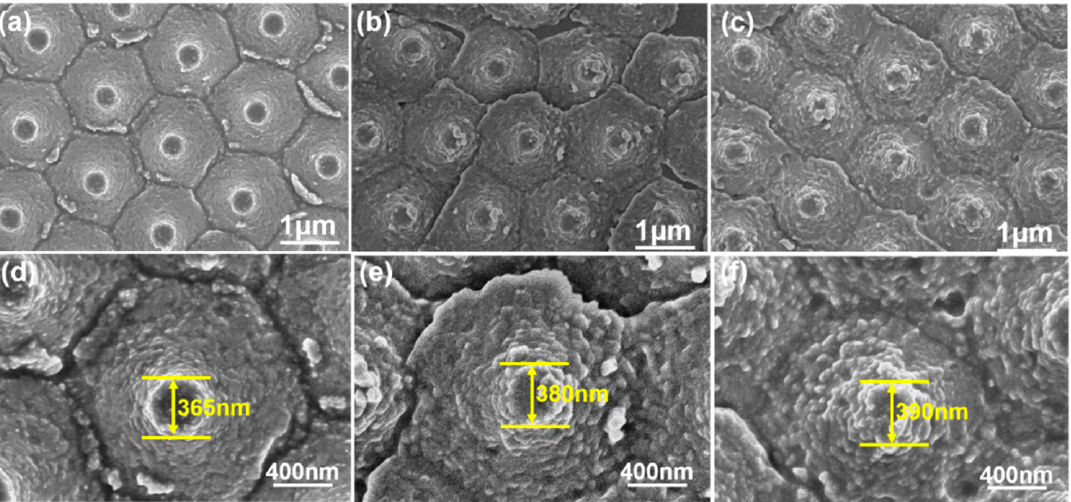
Figure 3. Low-magnification SEM images of the surface of a prepared ZnO seed layer on Al sacrificial layers of different thicknesses: ( a ) 120, ( b ) 420, and ( c ) 720 nm. High-magnification SEM images of the surface of a prepared ZnO seed layer on Al sacrificial layers of different thicknesses: ( d ) 120, ( e ), 420, and ( f ) 720 nm.